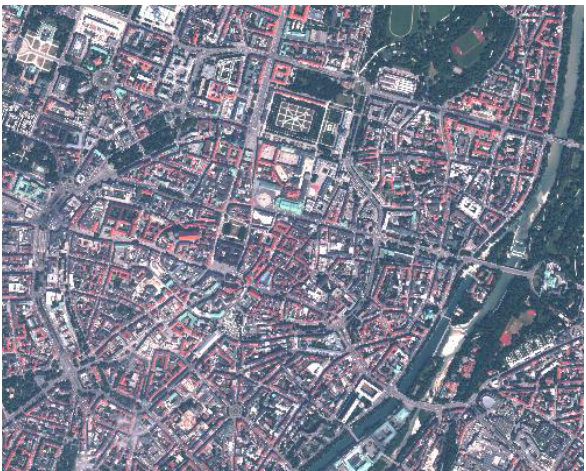
Figure 7. Section of the WorldView-2 Munich scene, 2500 m × 2000 m